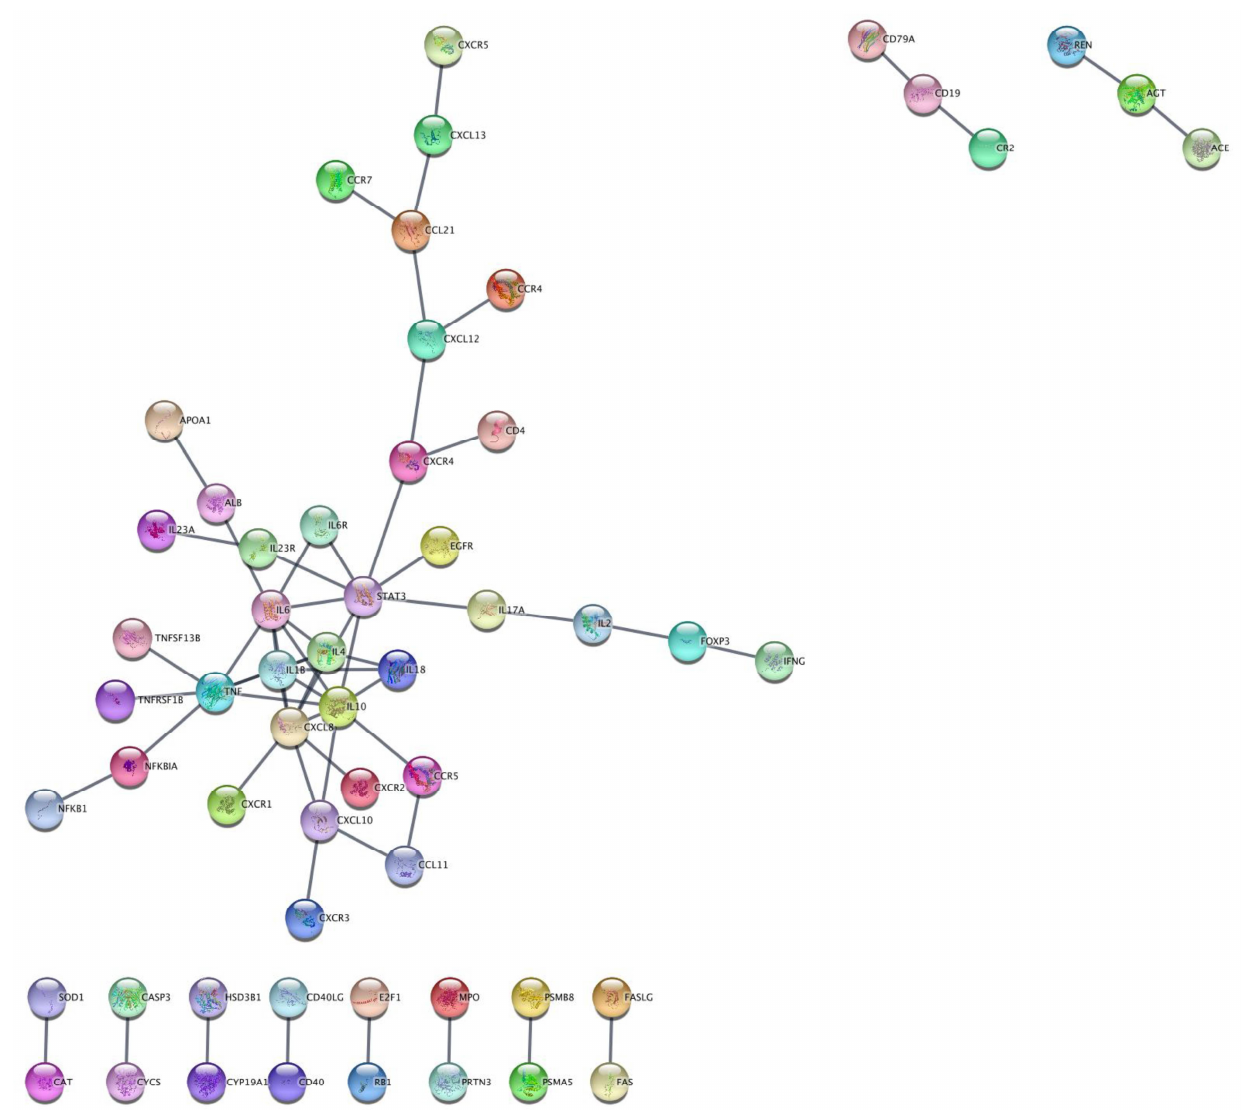
Figure 3. Cytoscape Protein–Protein Interaction Network of Xerostomia/Dry Mouth Network Intersection. Cytoscapev3.8.1:stringAppv1.6.0 protein–protein interaction network of xerostomia (input = 128 genes) and dry mouth (input = 55 genes) intersection (genes with matching name or Ensembl ID) with a 0.98 confidence score. The total number of returned genes in the network intersection is 58.